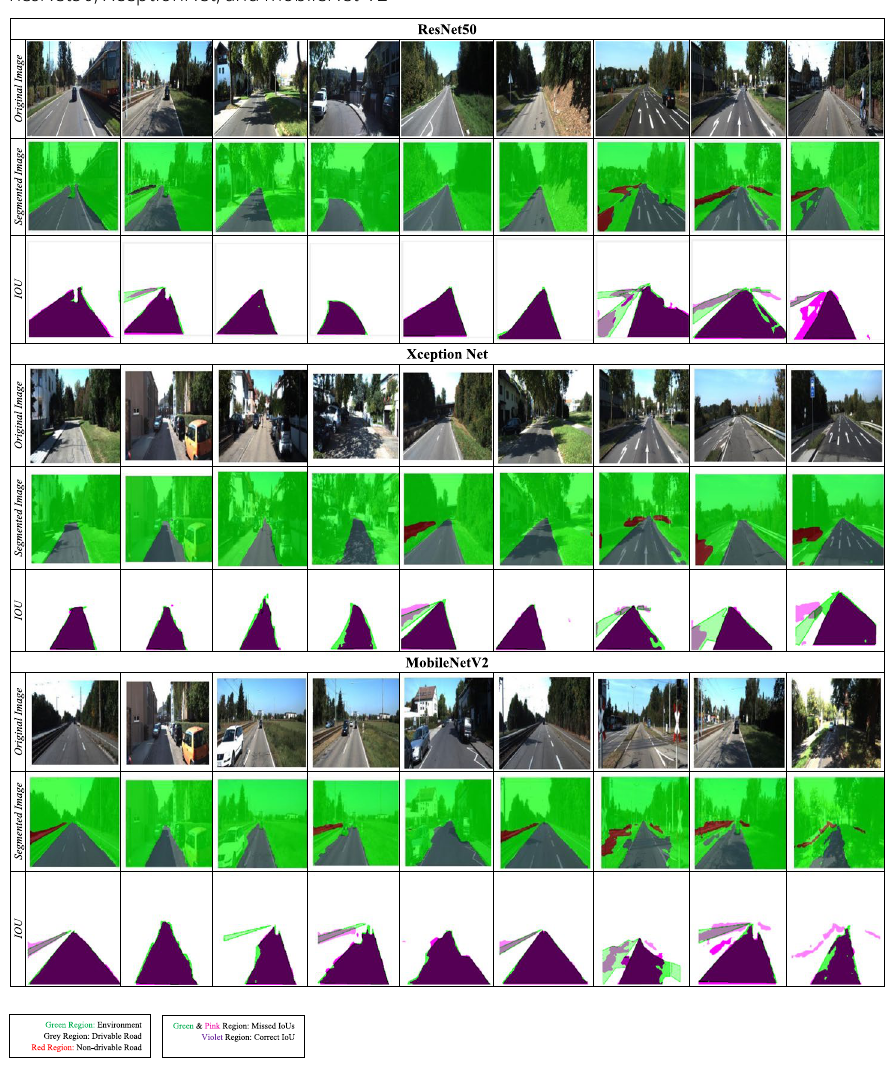
Table 2 The segmented road and environment regions and their respective IOUs obtained using ResNet50, XceptionNet, and